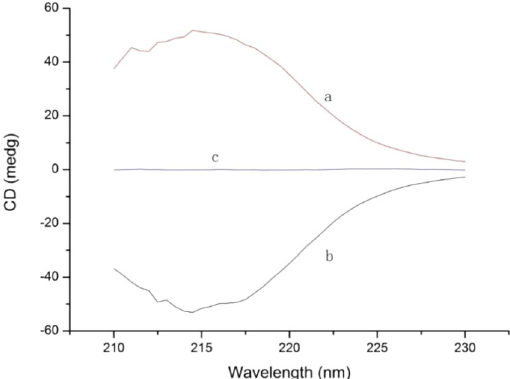
Figure 1. The circular dichroism spectra of L- and D-phenylalanine. (a and b) Are the circular dichroism spectra of the same amount of L- and D-phenylalanine, respectively. They have an approximately equal but opposite signal. (c) Is the spectrum from a mixture (racemate) of the same amount of L- and